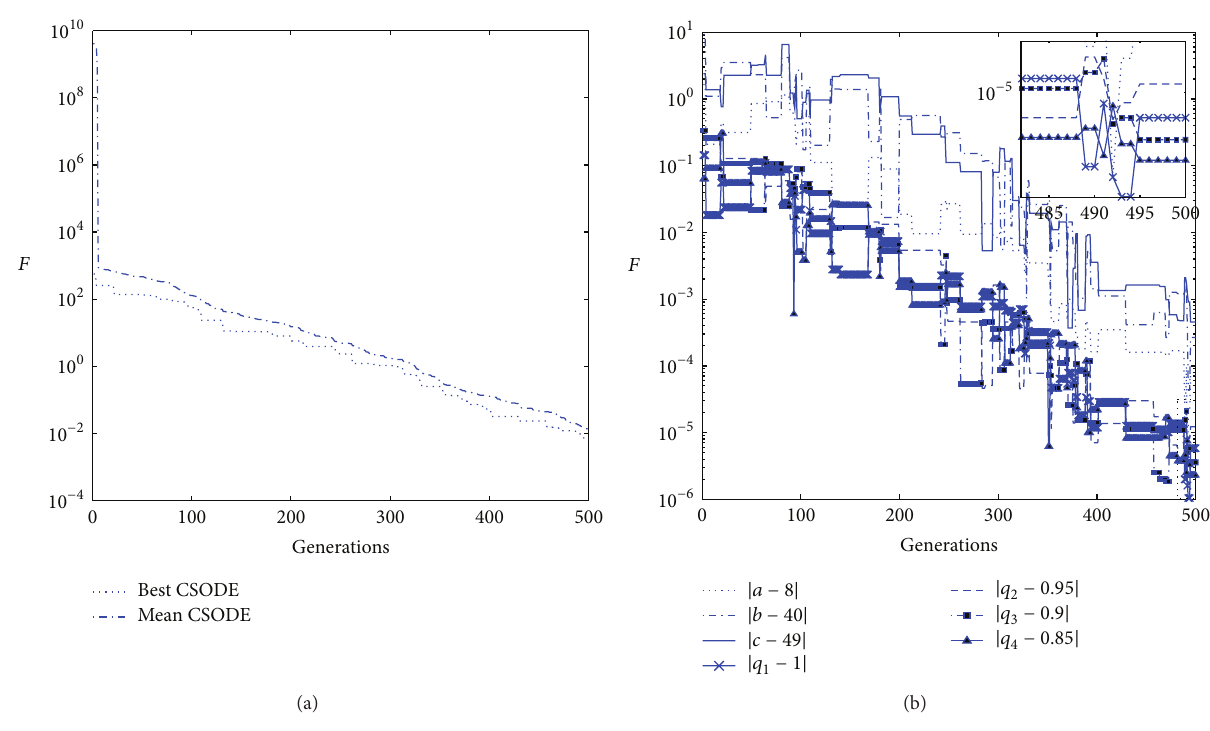
Figure 11: Evolution process for fractional-order four-wing system